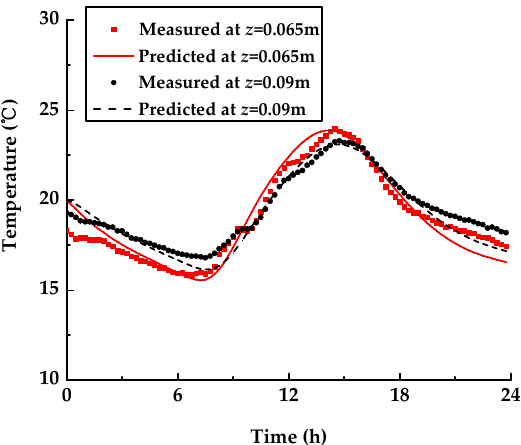
Figure 9. Measured and predicted temperature at z = 0.065 m and z = 0.09 m on 16 December.